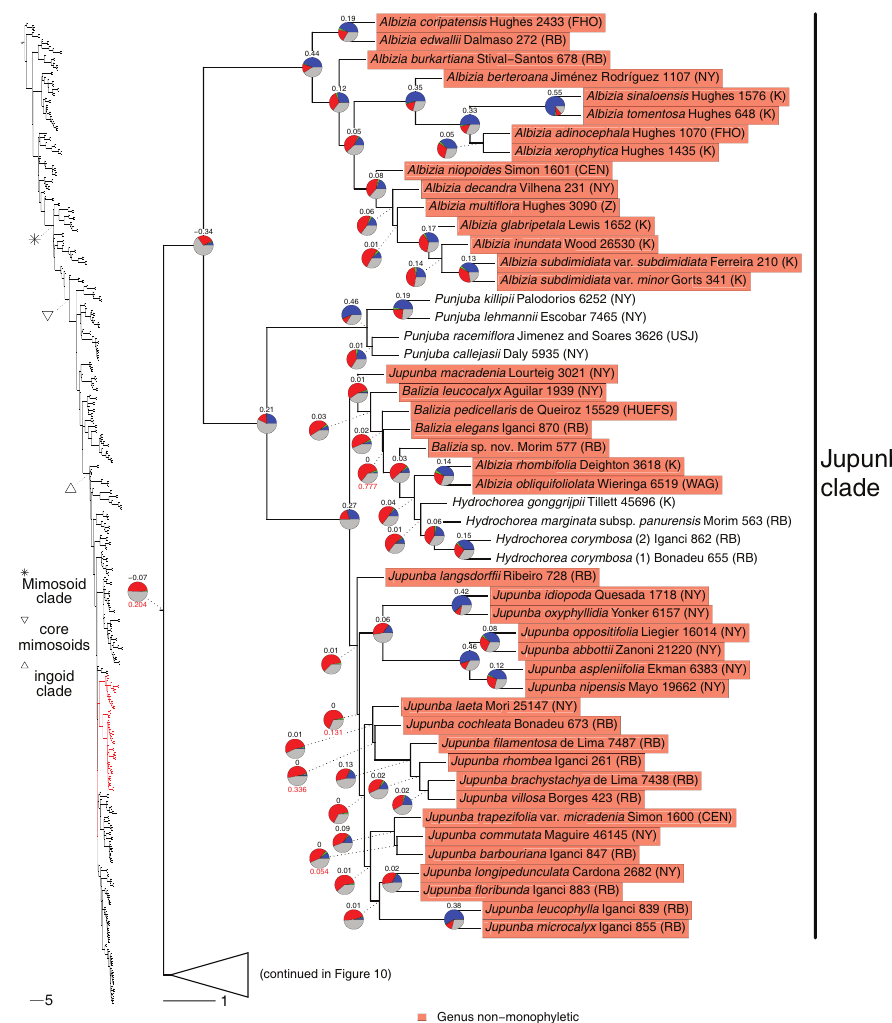
Figure 9. Phylogeny of Caesalpinioideae (continued). See Fig. 2 for